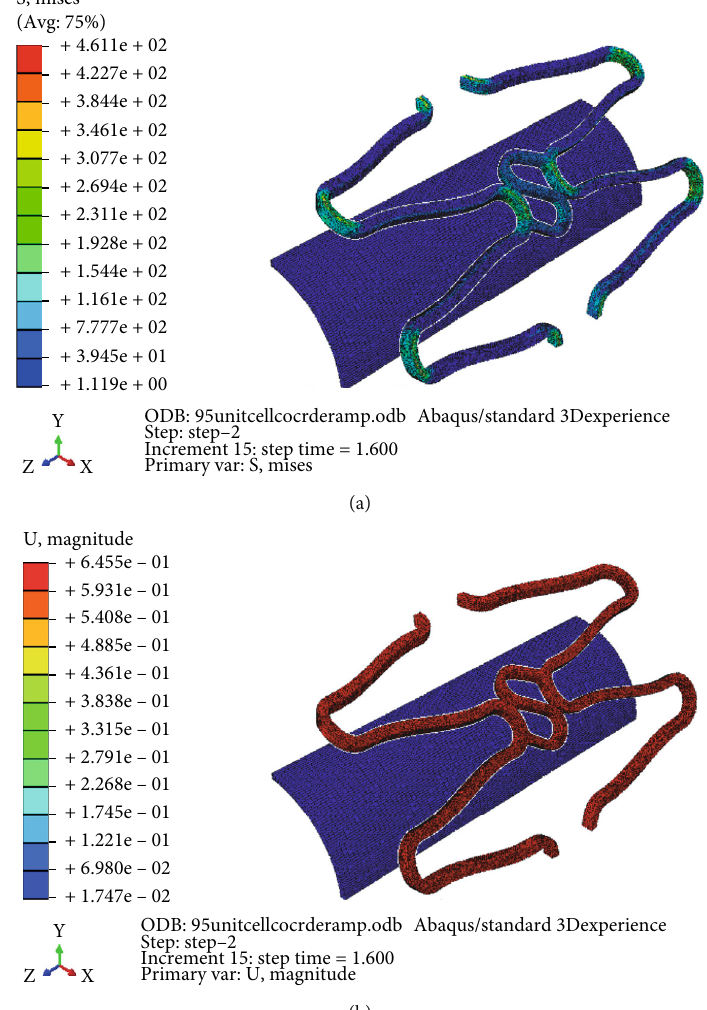
Figure 13: (a) Model A: stress distribution after de fl ation. (b) Model A: strain distribution after de fl